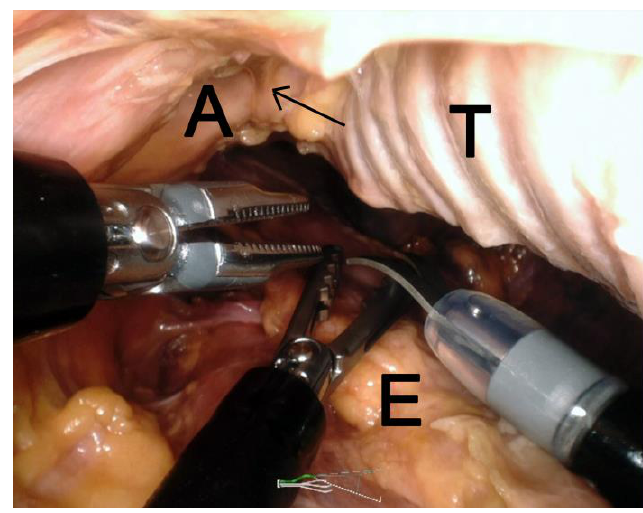
Figure 4. Paratracheal view of the left side of the trachea (T) in the upper mediastinum. (E) esophagus; (A) aortic arch; arrow points to right recurrent nerve.